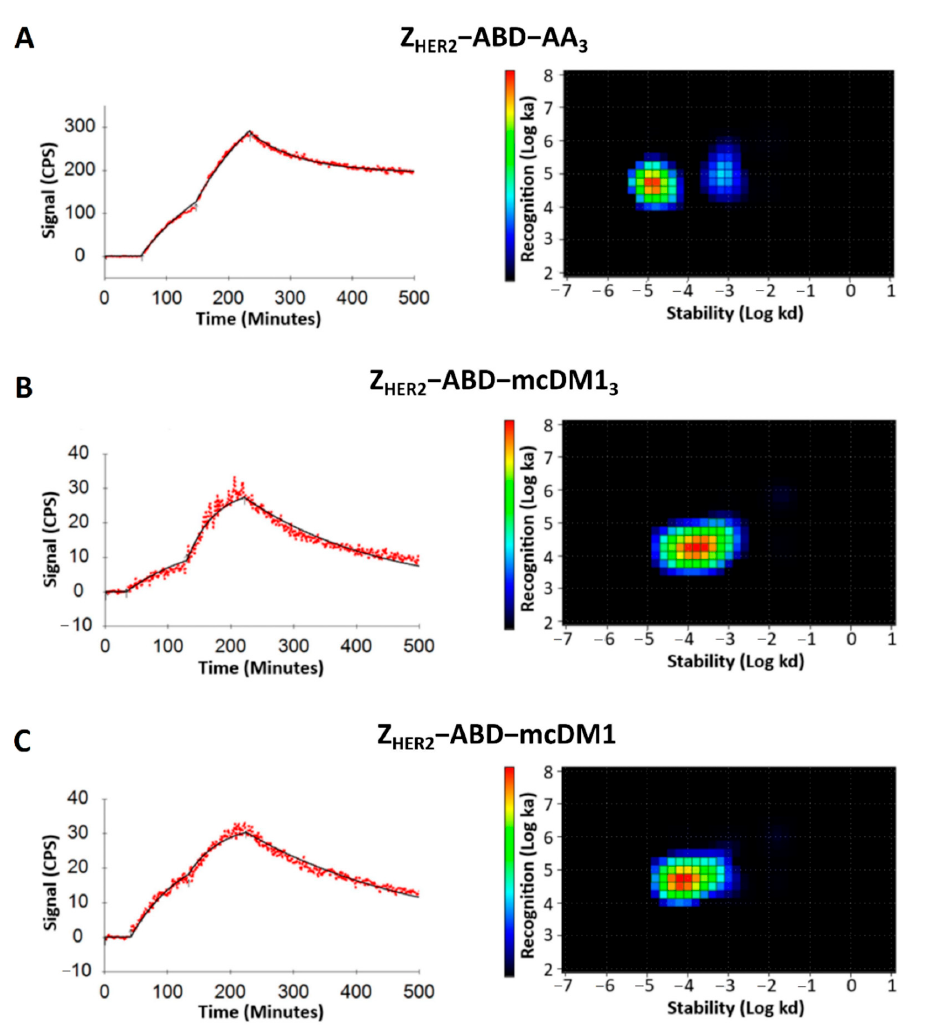
Figure 6. Real-time binding data and interaction map analysis of ( A ) Z HER2 –ABD–AA 3 , ( B ) Z HER2 –ABD–mcDM1 3, and ( C ) Z HER2 –ABD–mcDM1 to SKOV3 cells. For the real-time binding analyses to the left in each panel, the cells were incubated with the conjugates at a concentration of 1 nM for 90 min, followed by 2 nM for 90 min to record data for the association phase. At 220 min, the conjugates were removed to record data for the dissociation phase. The interaction maps were derived from the real-time binding analyses and are shown to the right in each panel, with the logarithm of the dissociation rate on the x-axis and the logarithm of the association rate on the y-axis.